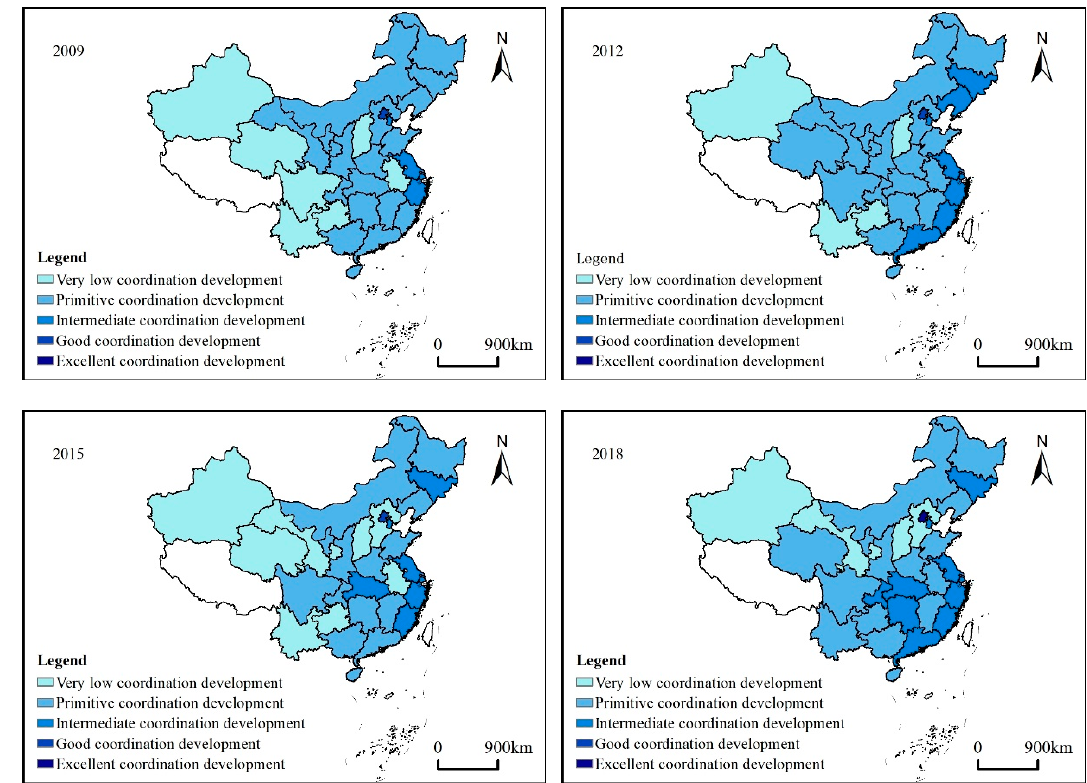
Figure 2. A diagram of China’s coordination level in regard to carbon emissions, economic development, and environmental protection.